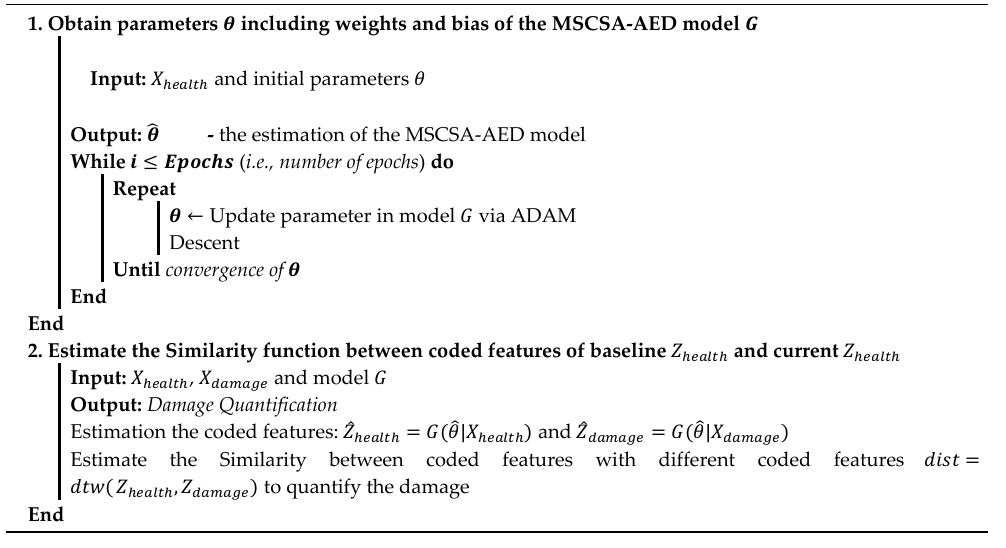
Algorithm 1 MSCSA-AED module with Similarity Function estimation for damage quantification